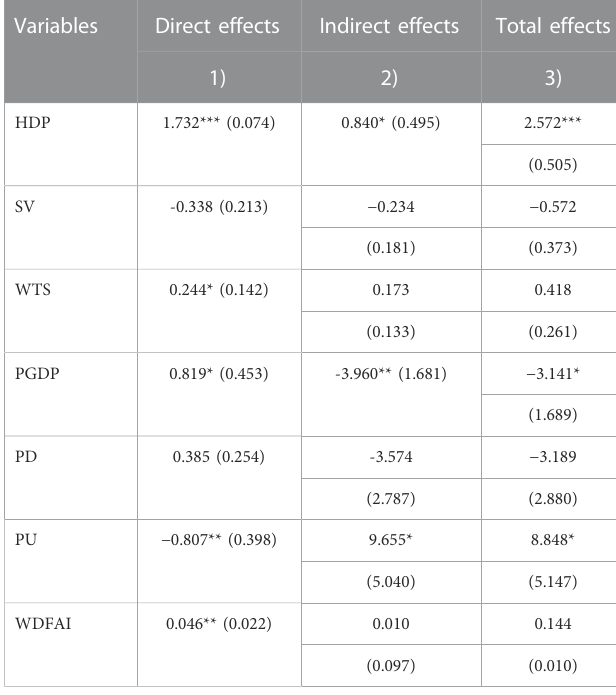
TABLE 6 The spatial effect decomposition. Variables Direct